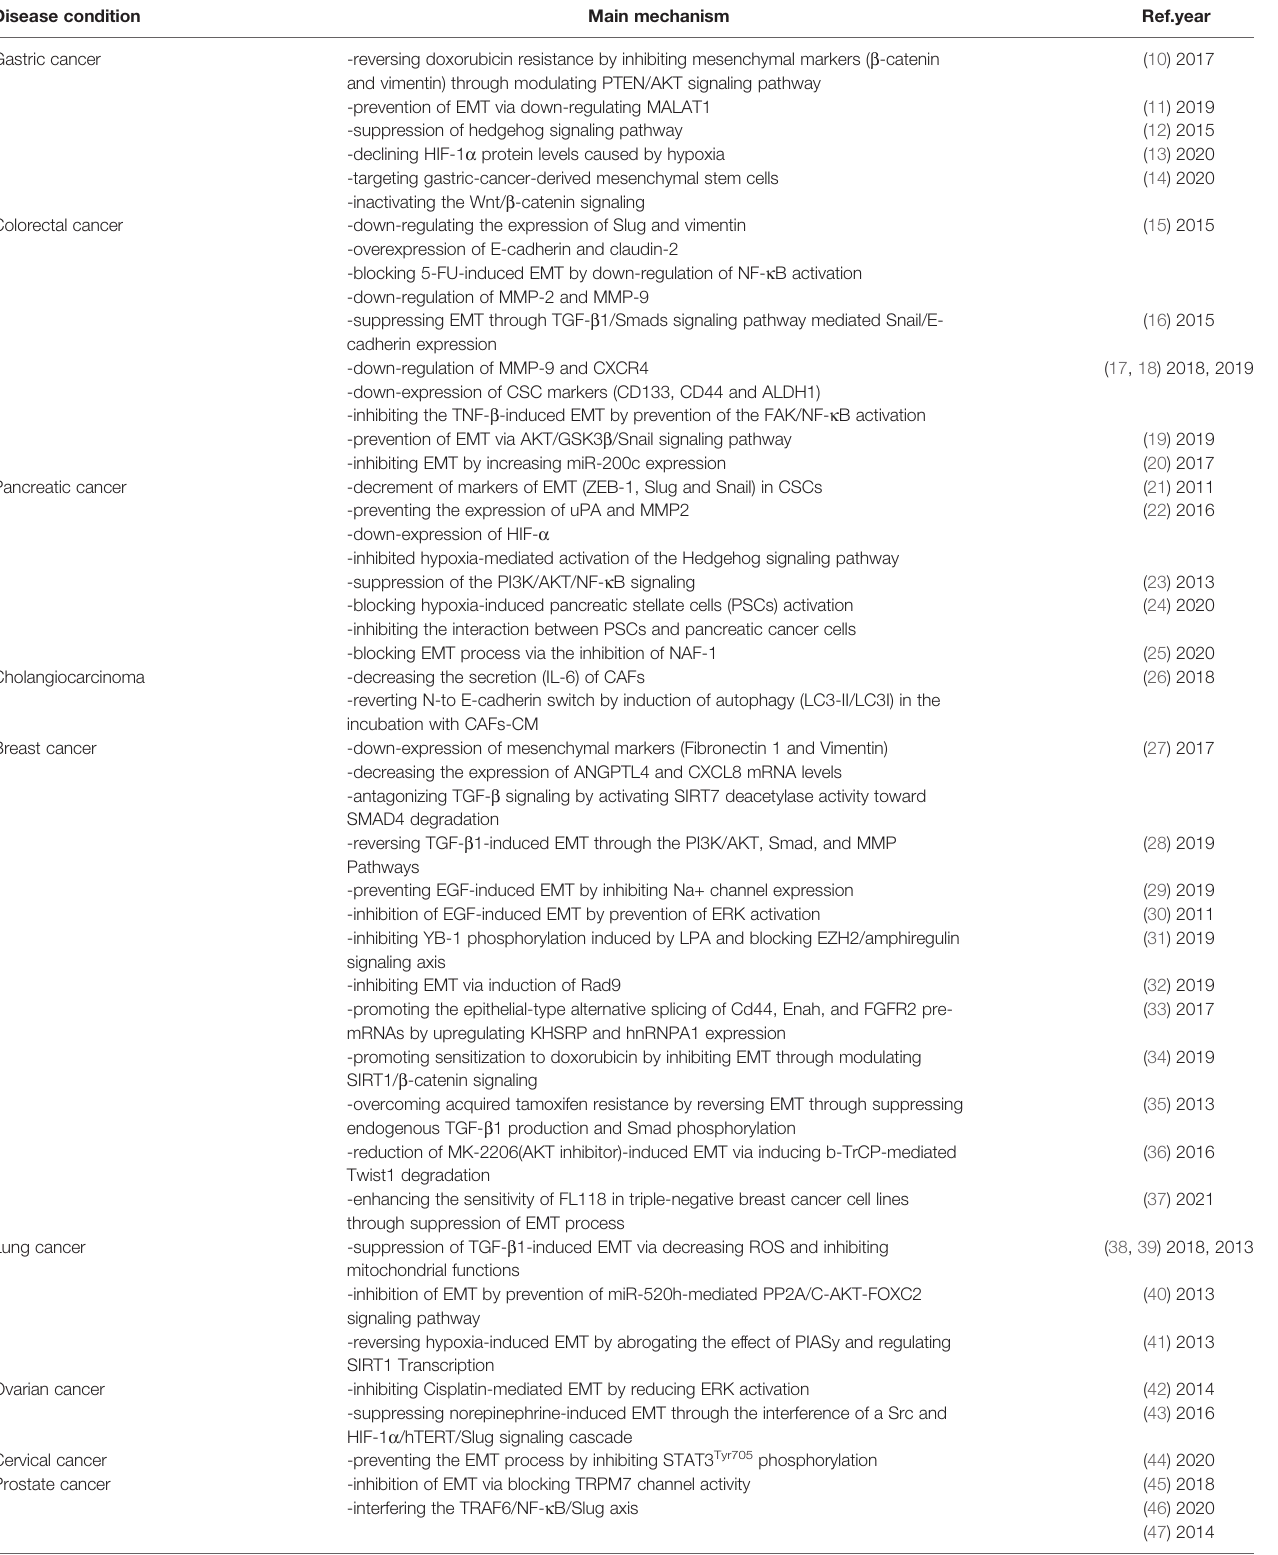
TABLE 1 | Summary of mechanisms by which resveratrol inhibits the EMT